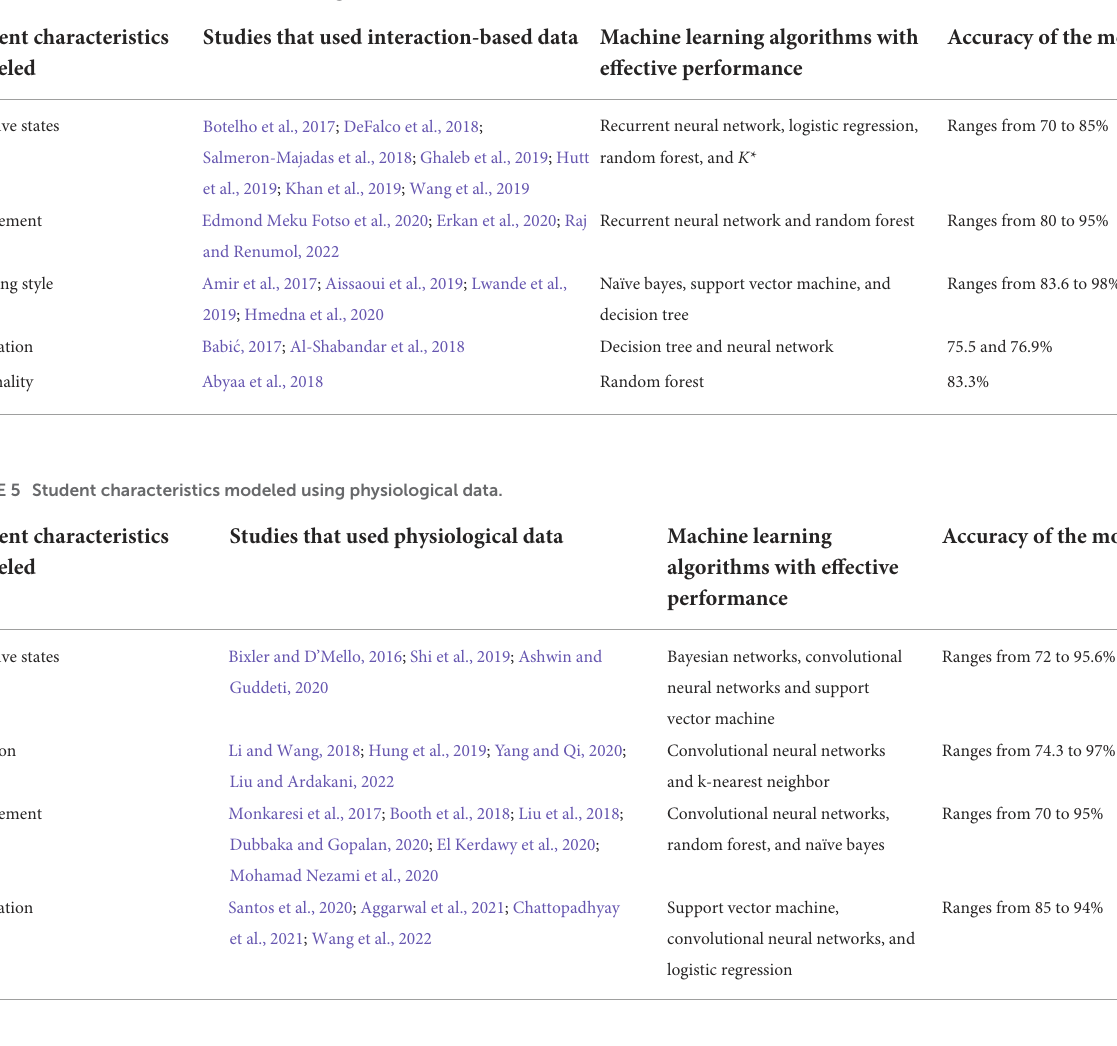
TABLE 4 Student characteristics modeled using interaction-based data.